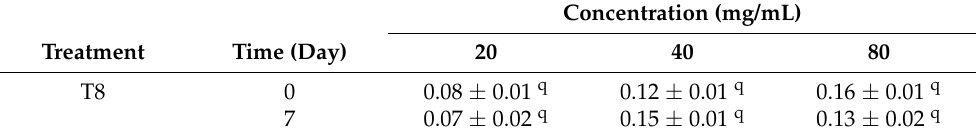
Concentration (mg/mL)